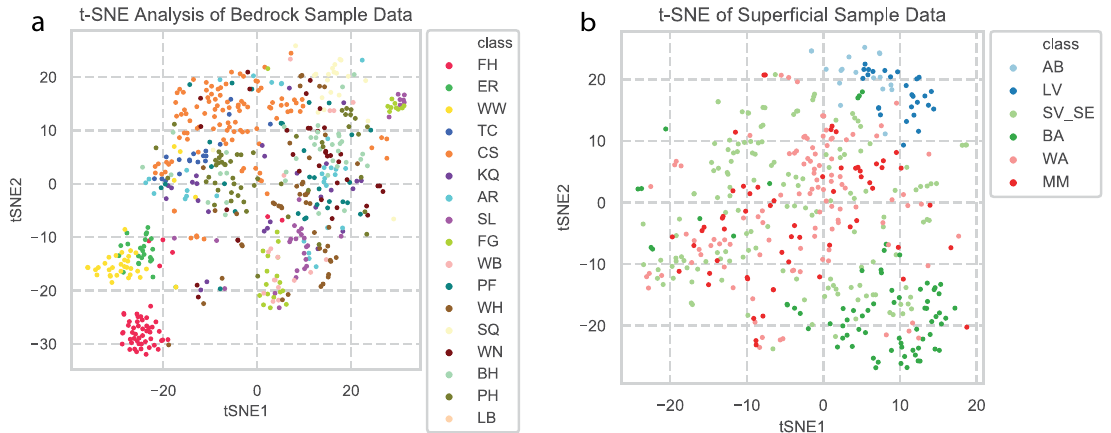
Figure 2. t-SNE plots of geochemical data. ( a ) Plot shows t-SNE coordinates for bedrock source coloured by location. ( b ) Plot shows t-SNE coordinates for superficial source coloured by